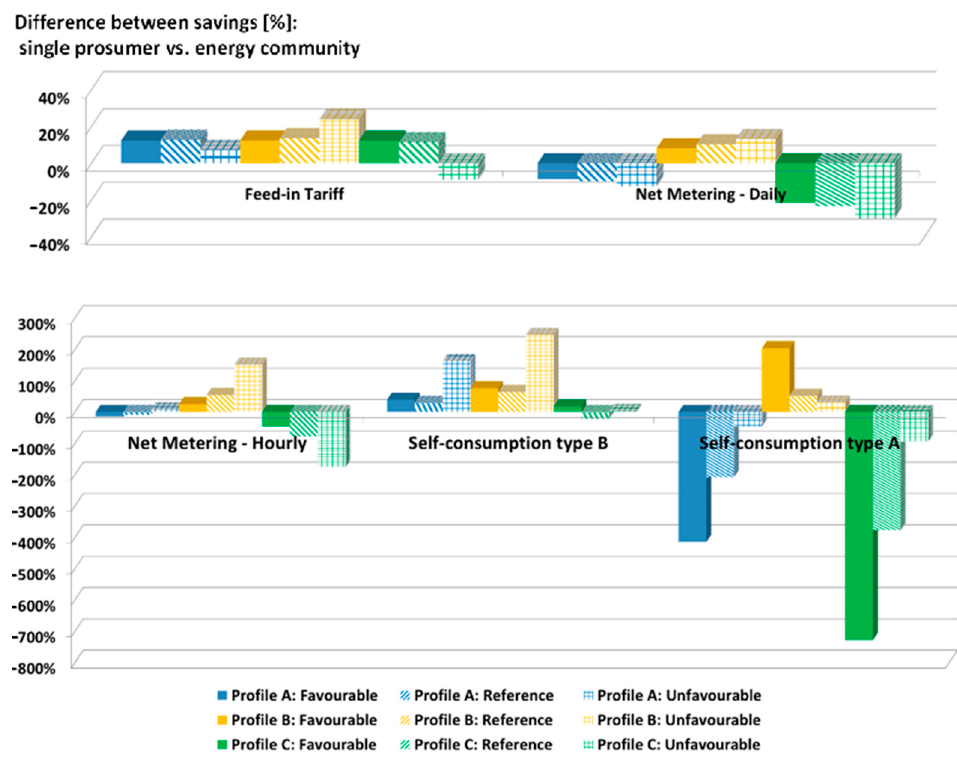
Figure 15. Comparative analysis of the energy economic results. Energy assets without ESS. Source: self-elaboration.